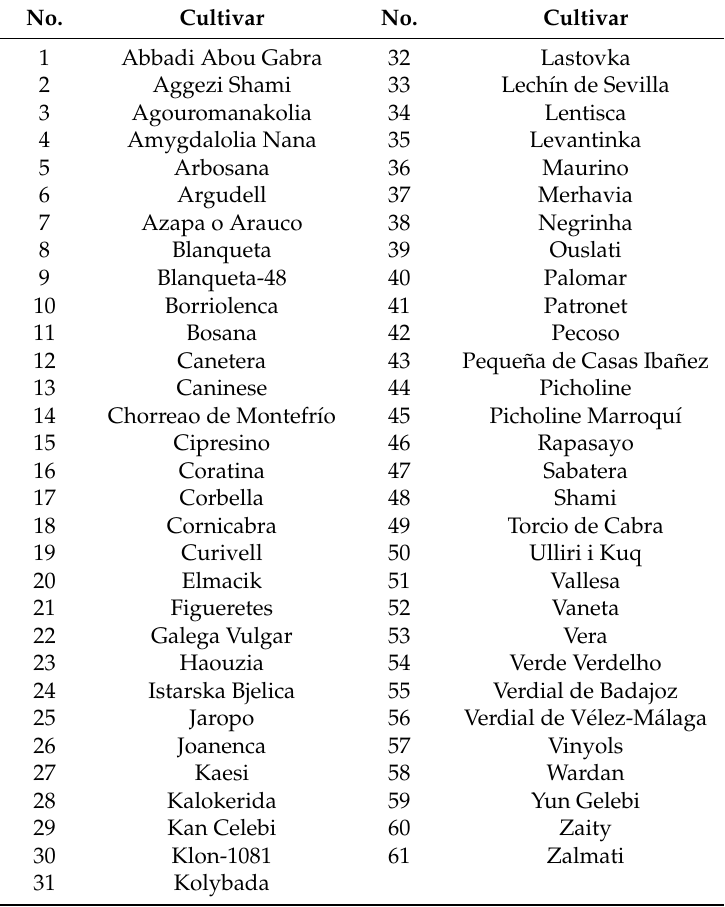
Table 1. Cultivars selected from the World Olive Germplasm Collection (WOGC, Cordoba, Spain). No. Cultivar